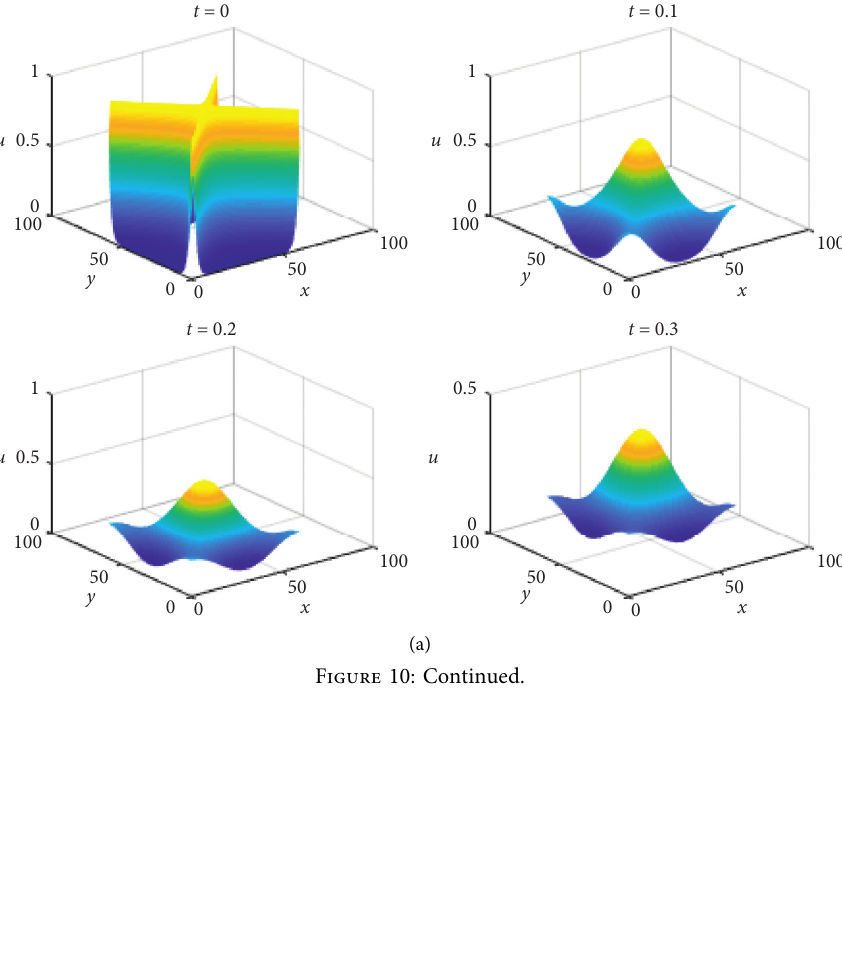
� 2 . 71 , d � 2 . 5 , and d � 11 12 22